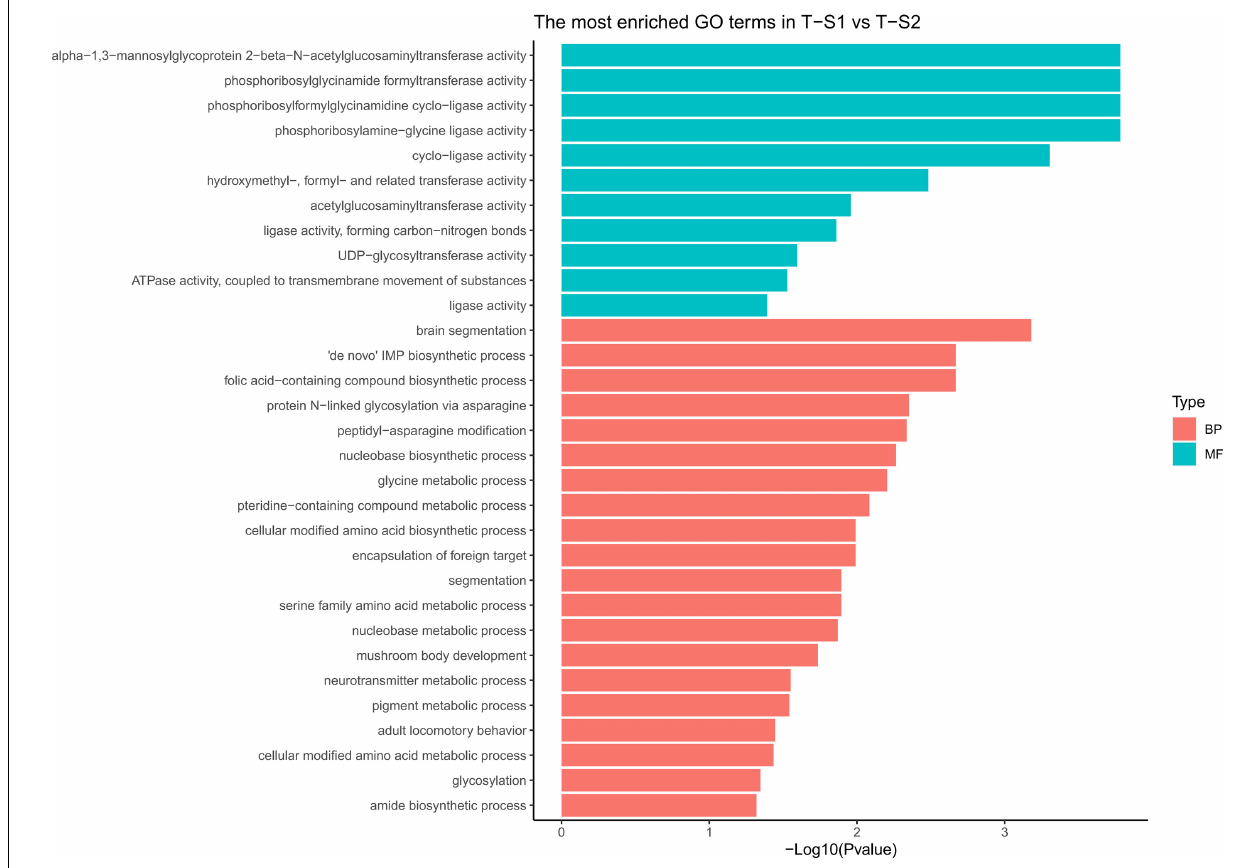
FIGURE 5 | Histograms of the enriched biological processes (BP) and molecular functions (MF) from the genes with differentially methylated positions in individuals from the depth treatment samplings in T-S1 vs. T-S2 (T-S1, T-S2 = depth treatment at sampling times 1 and 2, respectively).